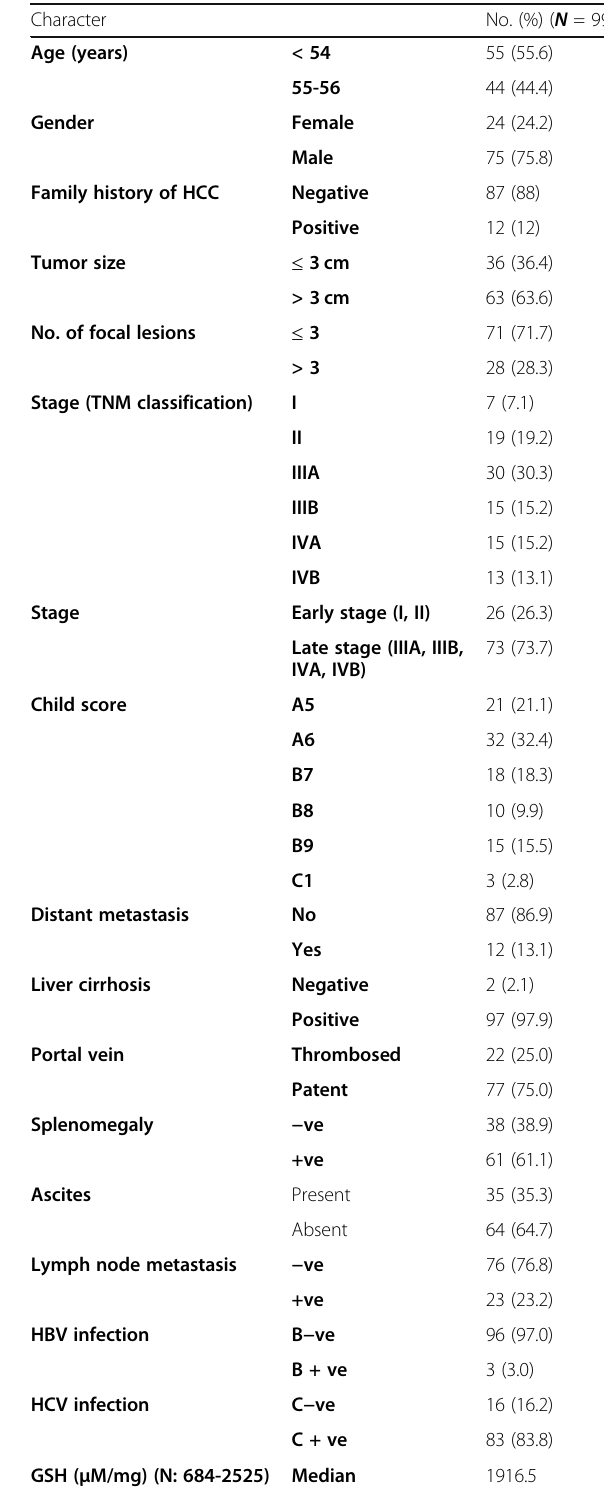
Table 1 Descriptive analysis of HCC patients ’